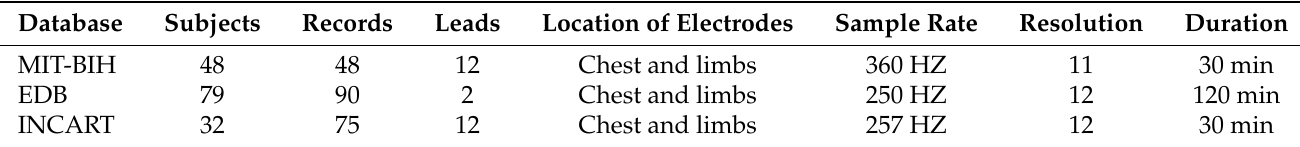
Table 3. Details of the ECG databases used in the evaluation